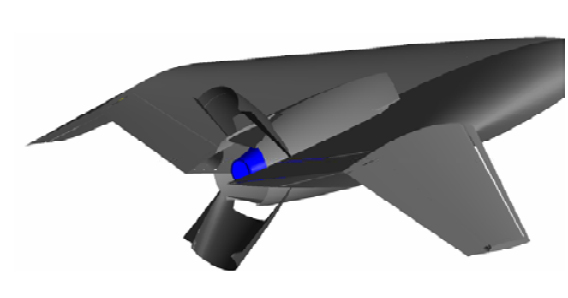
Fig 39. Clean configuration from a top-back-side view.